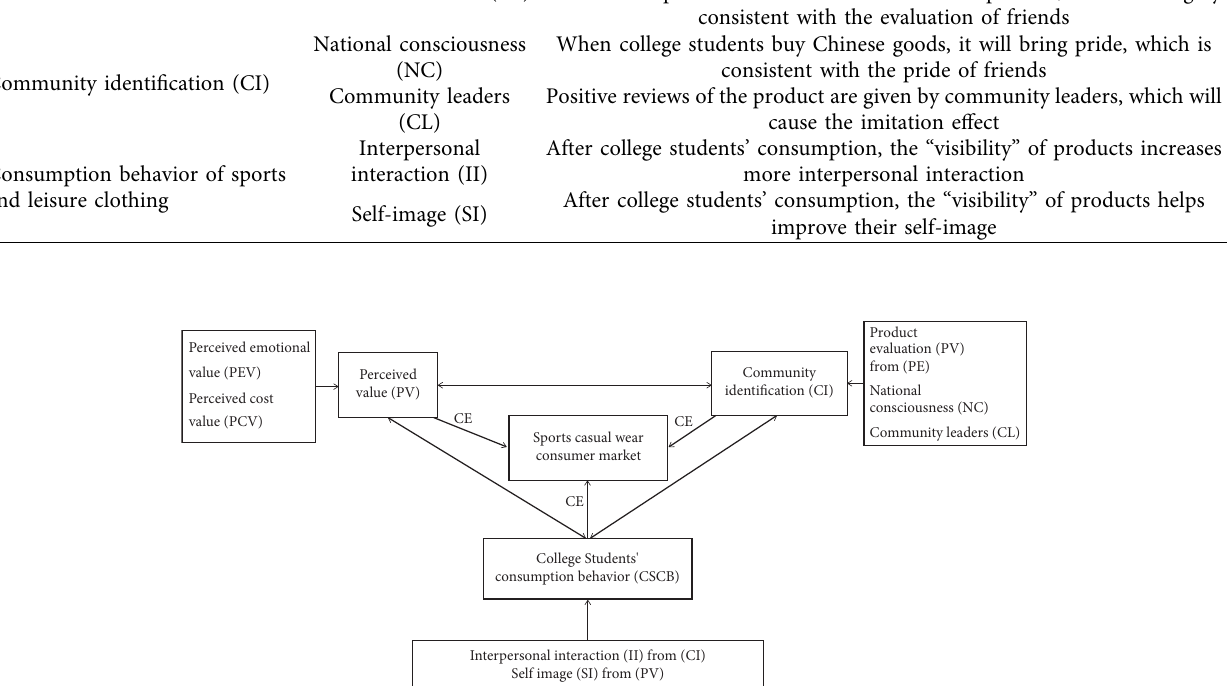
Figure 1: Model and selective coding